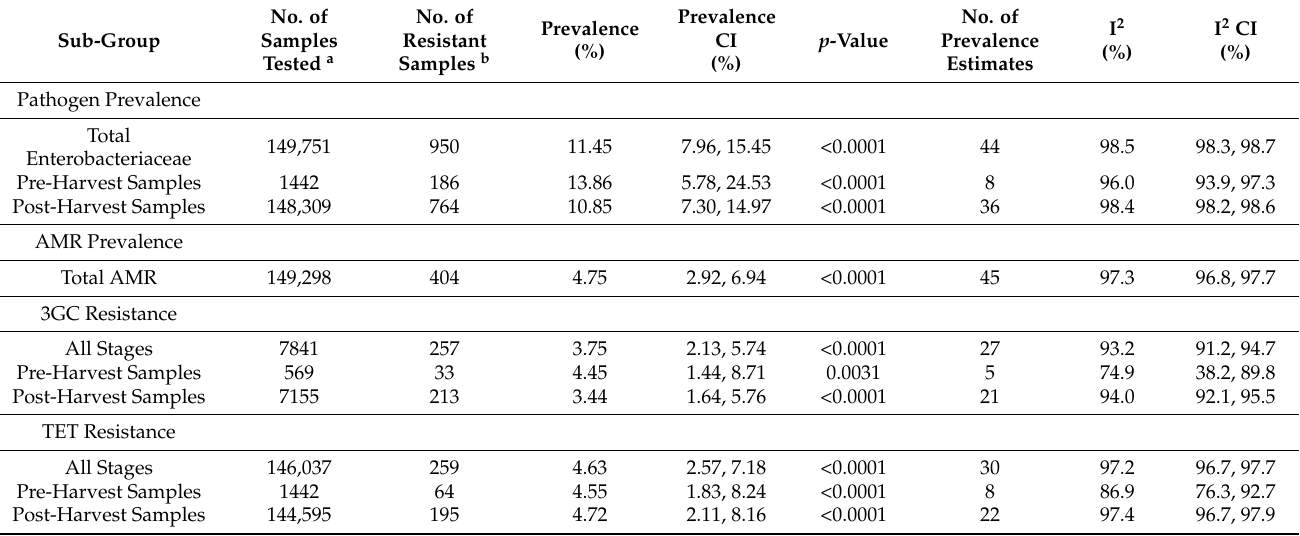
Table 2. Pooled prevalence estimates of Enterobacteriaceae and antimicrobial resistance in food